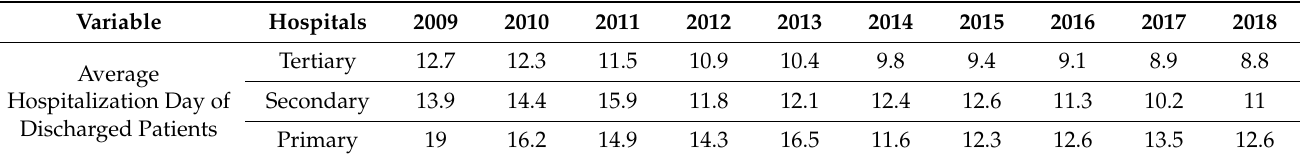
Table 14. The average hospitalization day of discharged patients of different level public hospitals in Beijing from 2009 to 2018